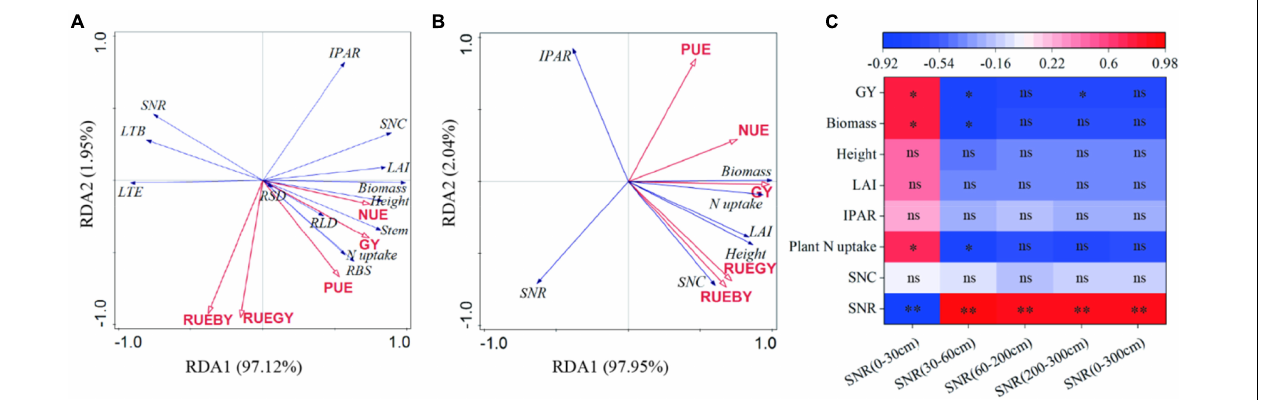
FIGURE 12 | Redundancy analysis (RDA) based on the grain yield (GY), nitrogen use efficiency (NUE), precipitation use efficiency (PUE), radiation use efficiency based on grain yield (RUE GY ), and radiation use efficiency based on biomass yield (RUE BY ) of summer maize (A) and winter wheat (B) . Correlation analysis between indexes of winter wheat season and nitrate nitrogen residue (SNR) at harvest of previous crop (summer maize) (C) . SNC, soil nitrate nitrogen concentration; LAI, leaf area index; IPAR, intercepted photosynthetically active radiation; RLD, root length density; RSD, root surface area density; LTB, light transmittance at bottom; LTE, light transmittance at ear layer; RBS, rate of root bleeding sap. ns, no significant correlation; ∗ , significant at P < 0.05; ∗∗ , significant at P <